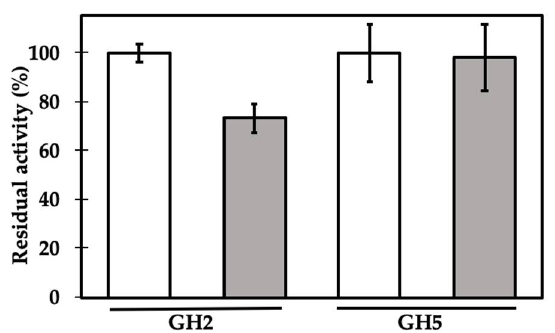
Figure 2. Enzyme residual activity in the absence (white bars) and in the presence of γC at a molar ratio of 1:1 (gray bars). GH2 and GH5 stand for β-mannosidase from Cellulomonas fimi and for xyloglucan-specific-endo-β-1,4-glucanase from Paenibacillus polymyxa , respectively. Residual activity was calculated as (AE-AEI)/AE × 100, where AE is the measured enzyme activity (mmol/min) and AEI is the activity of the enzyme in the presence of γC. See text for experimental details. Each point is the mean of three assays.